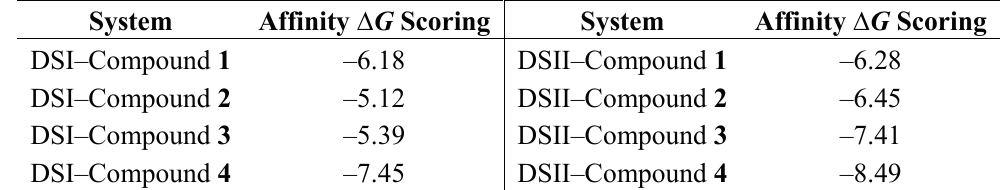
Table 4. Results for the affinity ∆ G scoring of molecular docking for BSA and compounds 1 – 4 (DSII refer to the main binding regions within domains II and III, named Sudlow’s